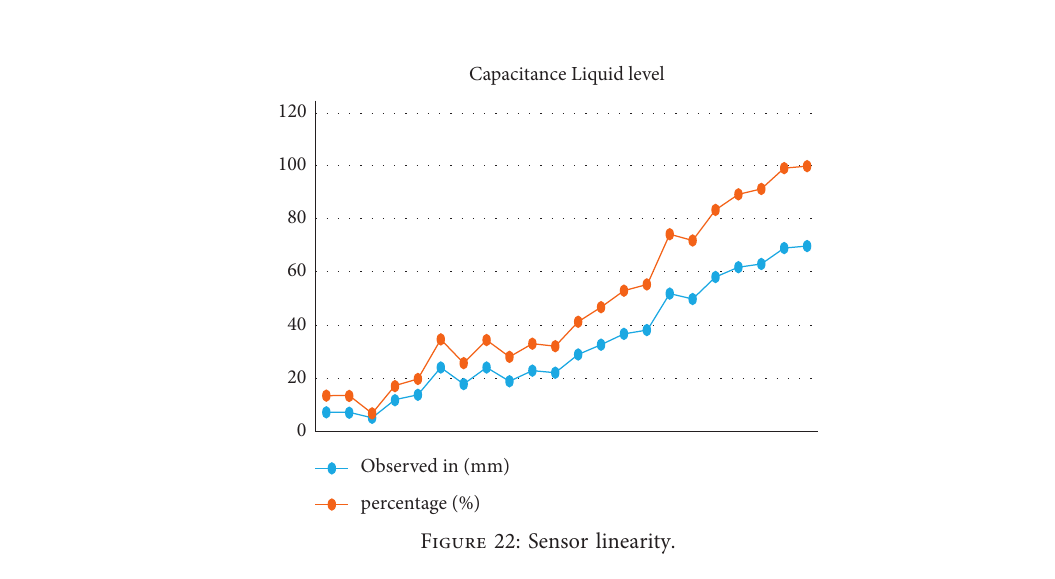
Figure 21: Rectification based on the peak voltage.